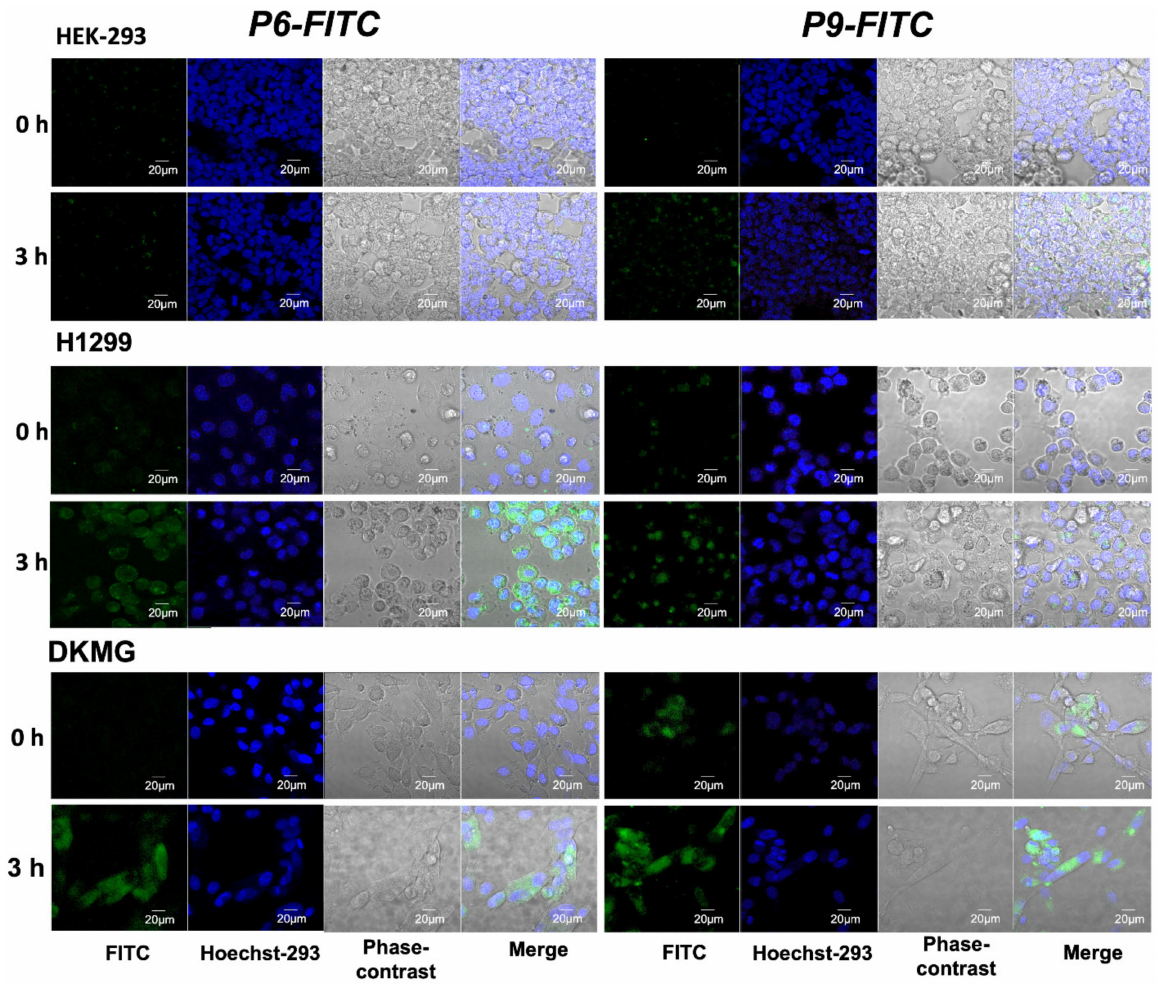
Figure 5. Intracellular localization of FITC-labeled P6 and P9 peptides. HEK-293, H1299, and DKMG . Cells were grown in glass-bottom black plates and incubated for 0 and 3 h at 37 ◦ C with 25 µ M of FITC-labeled P6 and P9 peptides. Cell nuclei were stained with Hoechst-293. After incubation, cells were washed three times with PBS (Ca 2+ and Mg 2+ ), fixed with 4% paraformaldehyde (PFA), and then analyzed by confocal laser microscopy. Magnification ×